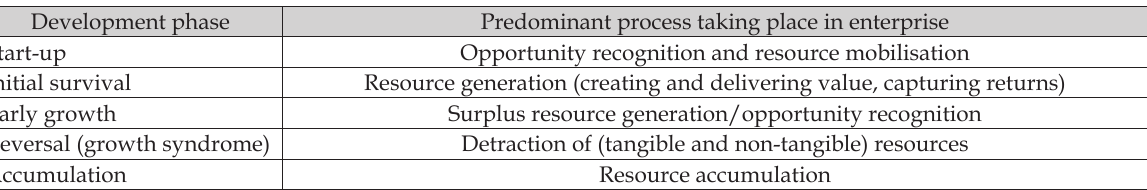
Table 2. Phases in the development of an enterprise and processes predominant in them. Development